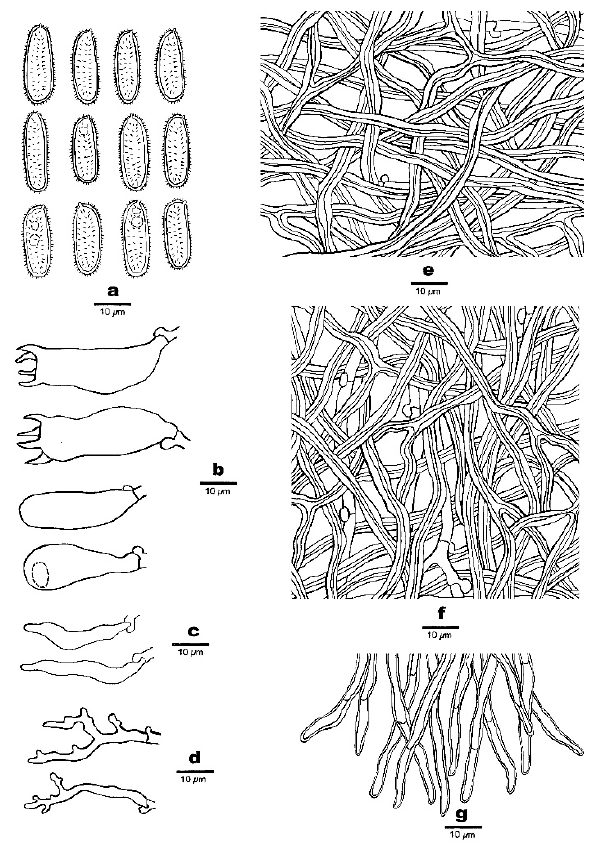
Figure 6. Microscopic structures of Haploporus longisporus (Holotype). ( a ). Basidiospores. ( b ). Basidia and basidioles. ( c ). Cystidioles. ( d ). Dendrohyphidia. ( e ). Hyphae from subiculum. ( f ). Hyphae from trama. ( g ). Hyphae at dissepiment